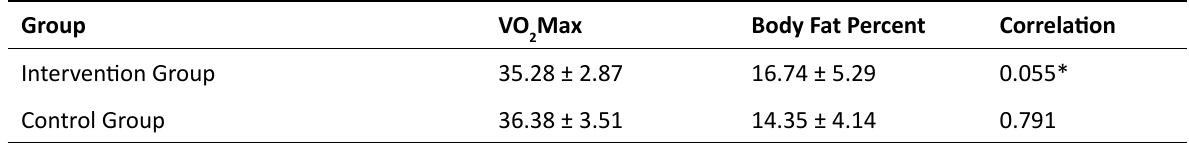
OF STUDENTS Table 4. Relationship between VO2Max and Body Fat Percent